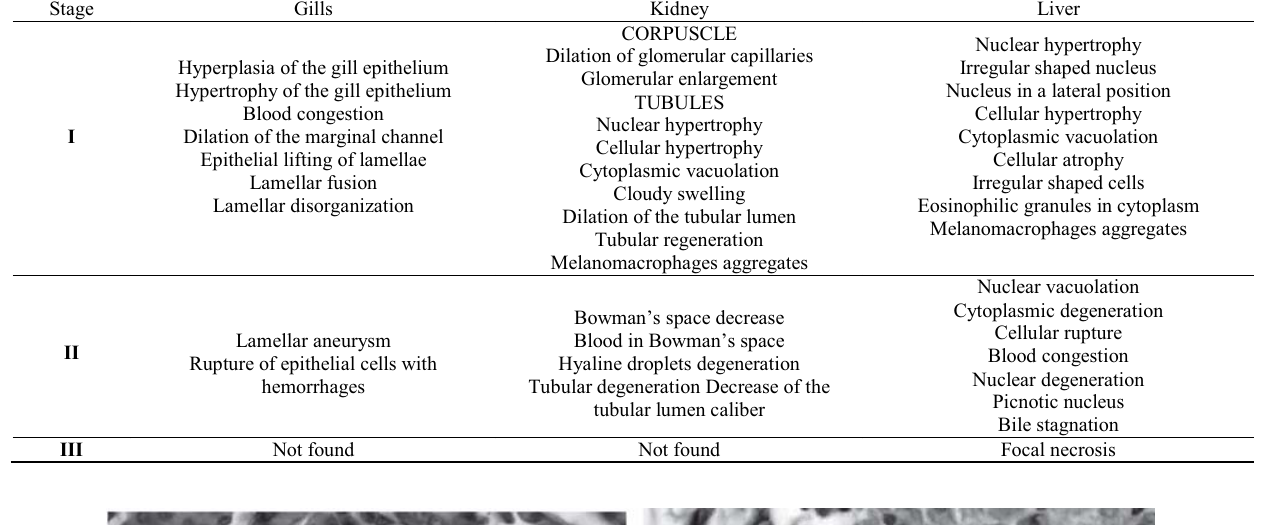
Table 2 . Histopathological changes in the gills, kidney and liver of P. lineatus caged at three sites along the upper reaches of Cambé stream and at the reference site indicating their respective stages of damage to the tissue. Stage I: do not alter the normal functioning of the tissue; Stage II: more severe and impair the normal functioning of the tissue; Stage III: very severe and cause irreparable damage.